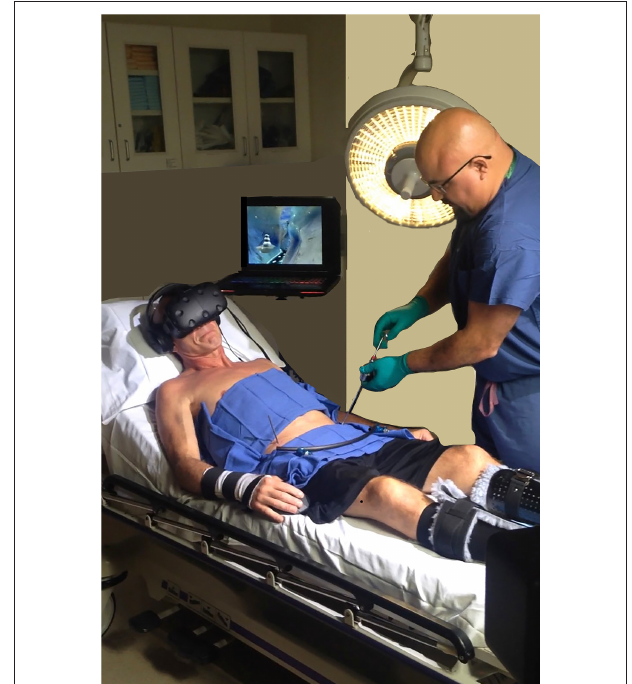
FIGURE 1 | A patient in VR during external fixator removal. Photo and copyright Hunter Hoffman,